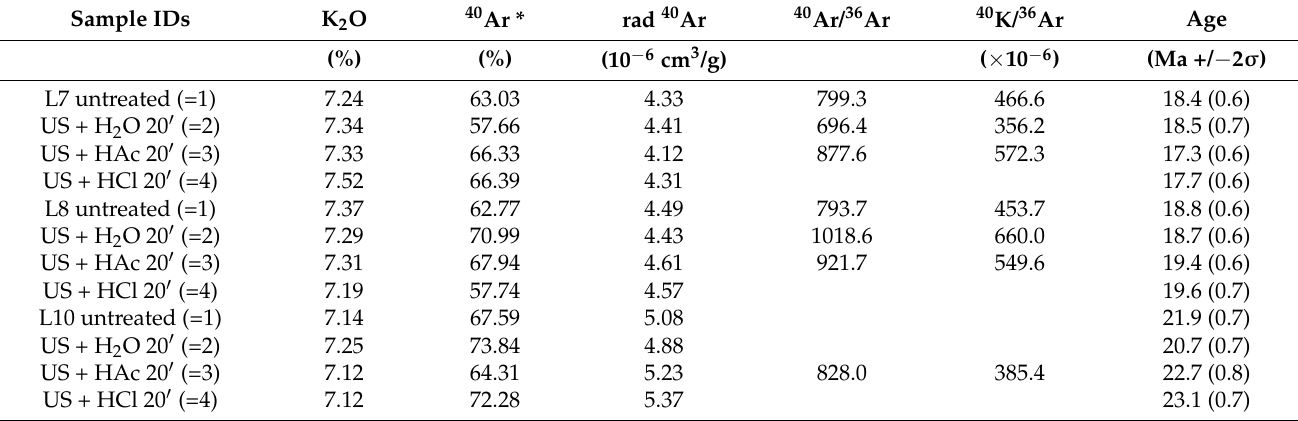
Table 3. K–Ar data of the untreated and leached glauconite